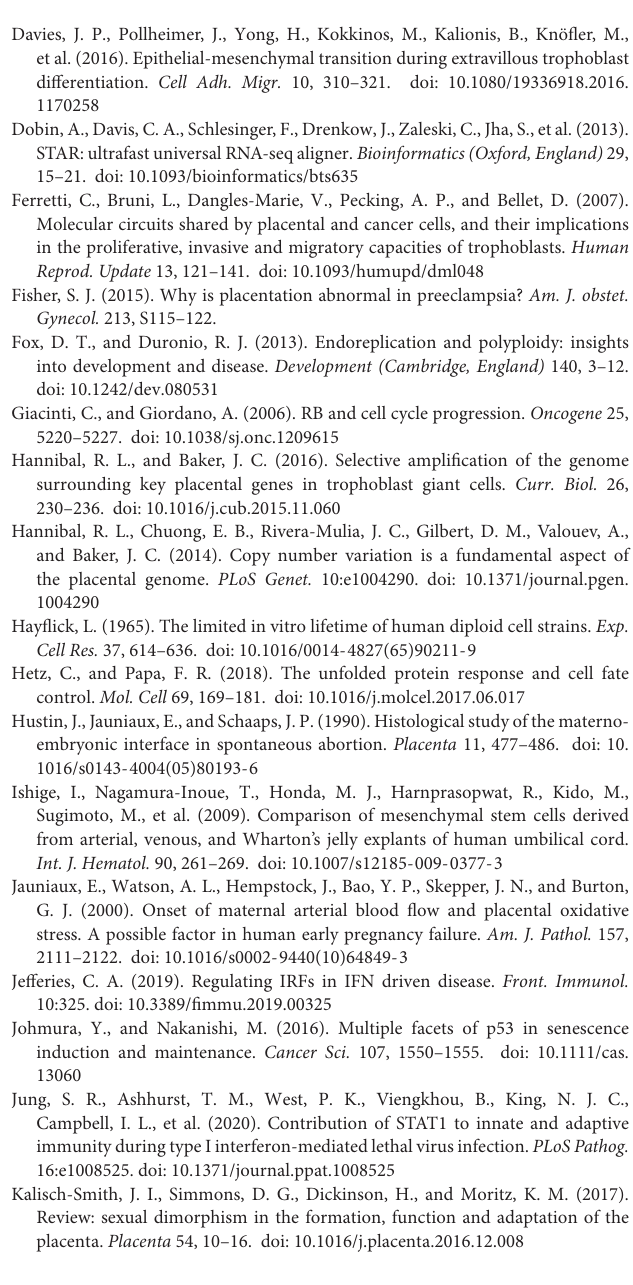
Supplementary Table 2 | List of primers used for